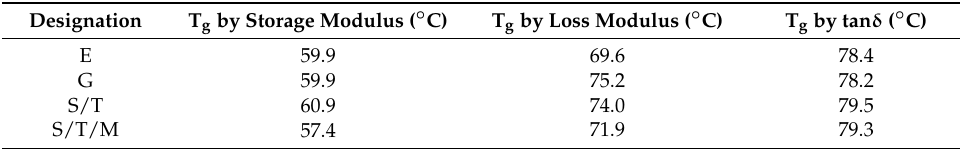
Table 3. Glass transition temperature, T g , of silk/epoxy compared to glass/epoxy and neat epoxy.